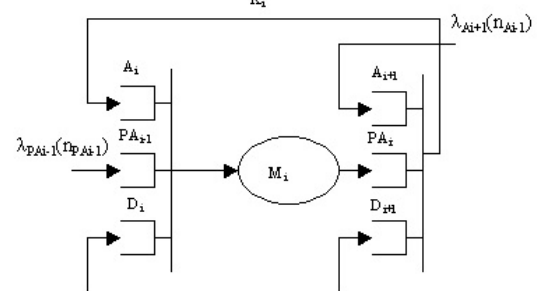
Figure 4. Model of a closed network for a single stage of the Extended Kanban